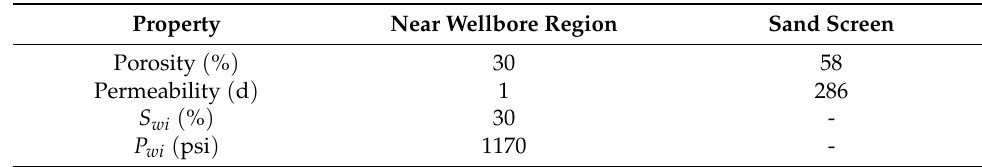
Figure 3. General view of ( a ) the geometry and boundary conditions for the complete AICD assembly and ( b ) a detailed explanation of the main parts of the AICD assembly. Table 2. Porous media physical properties and initial conditions.